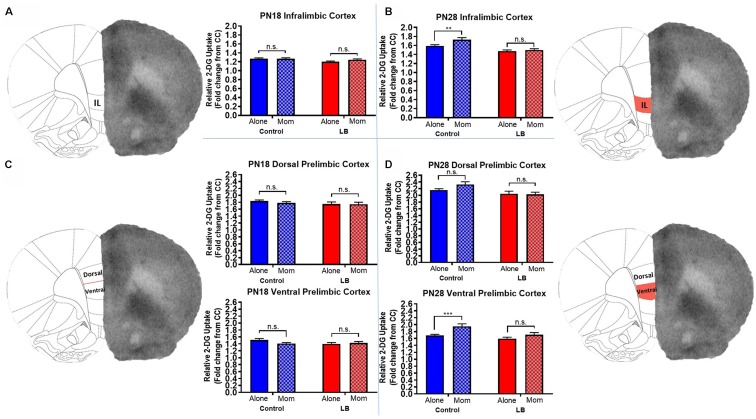
Previous abuse impairs maternal regulation of vmPFC regions during threat in older pups. Average (±SEM) fold change in activity for (A,C) PN18 Control infralimbic (IL: Alone n = 40; Mom n = 44; dorsal PL: Alone n = 41; Mom n = 33; ventral PL: Alone n = 30; Mom n = 33) and LB (IL: Alone n = 28; Mom n = 28; dorsal PL: Alone n = 28; Mom n = 21; ventral PL: Alone n = 21; Mom n = 21) or (B,D) PN28 Control (IL: Alone n = 32; Mom n = 28; dorsal PL: Alone n = 24; Mom n = 24; ventral PL: Alone n = 32; Mom n = 32) and LB (IL: Alone n = 32; Mom n = 298; dorsal PL: Alone n = 24; Mom n = 27; ventral PL: Alone n = 32; Mom n = 36). Solid bars represent pups conditioned alone while hashed bars represent pups conditioned with the mother. Right, schematics of brain regions; red, subregions with statistically significant effect of abuse on 2-DG uptake. n.s., indicates a non-significant effect (p > 0.05); **p < 0.01; ***p < 0.001.